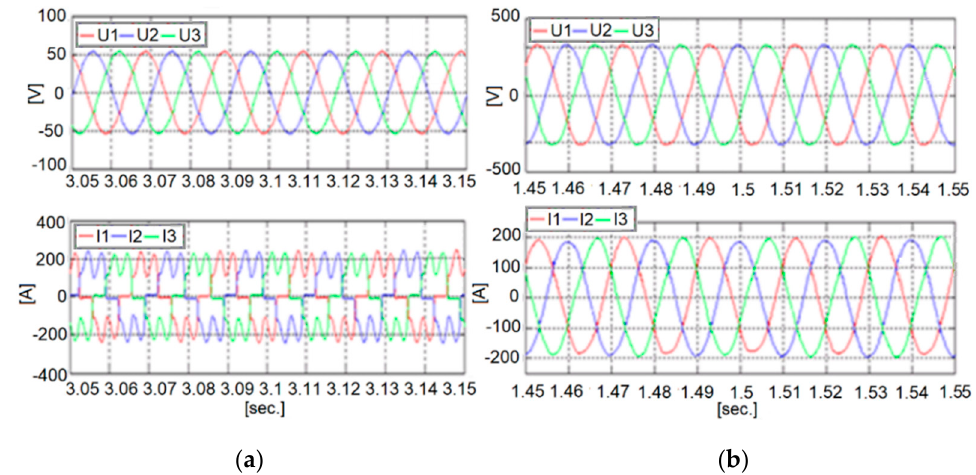
Figure 10. Top: Phase voltages supplying the three ‐ phase rectifier with diodes. Bottom: currents absorbed by rectifier: ( a ) before compensation; ( b ) after the filtering of the harmonic orders lower than 49—when the D.C. motor was supplied at its rated power. Table 1. Parameters of the most significant harmonics of the phase voltages—before compensation— case γ . V 1 V 2 V 3 Harmonic